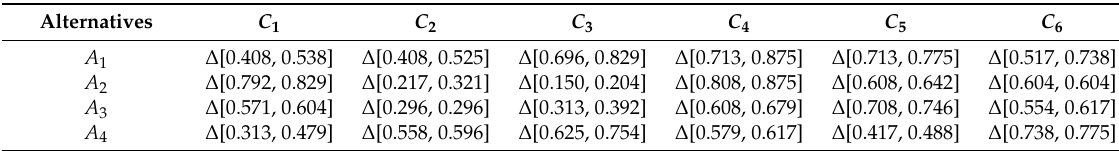
Table 4. Collective interval 2-tuple decision matrix.